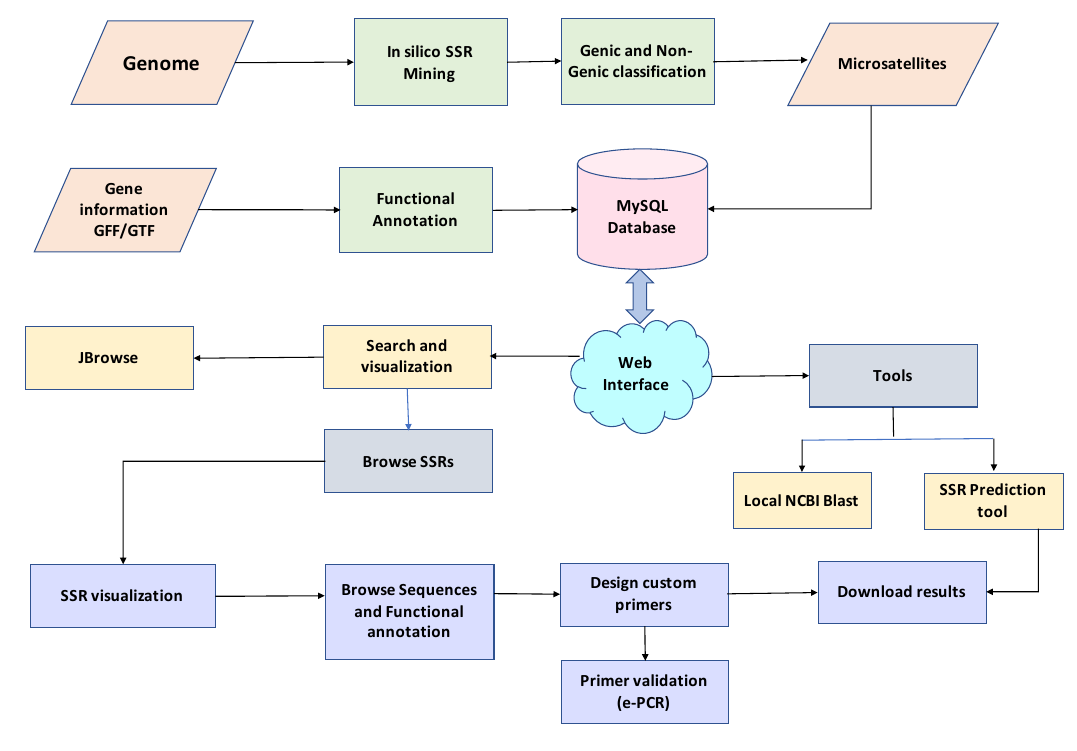
Figure 1. Overall workflow of legumeSSRdb .